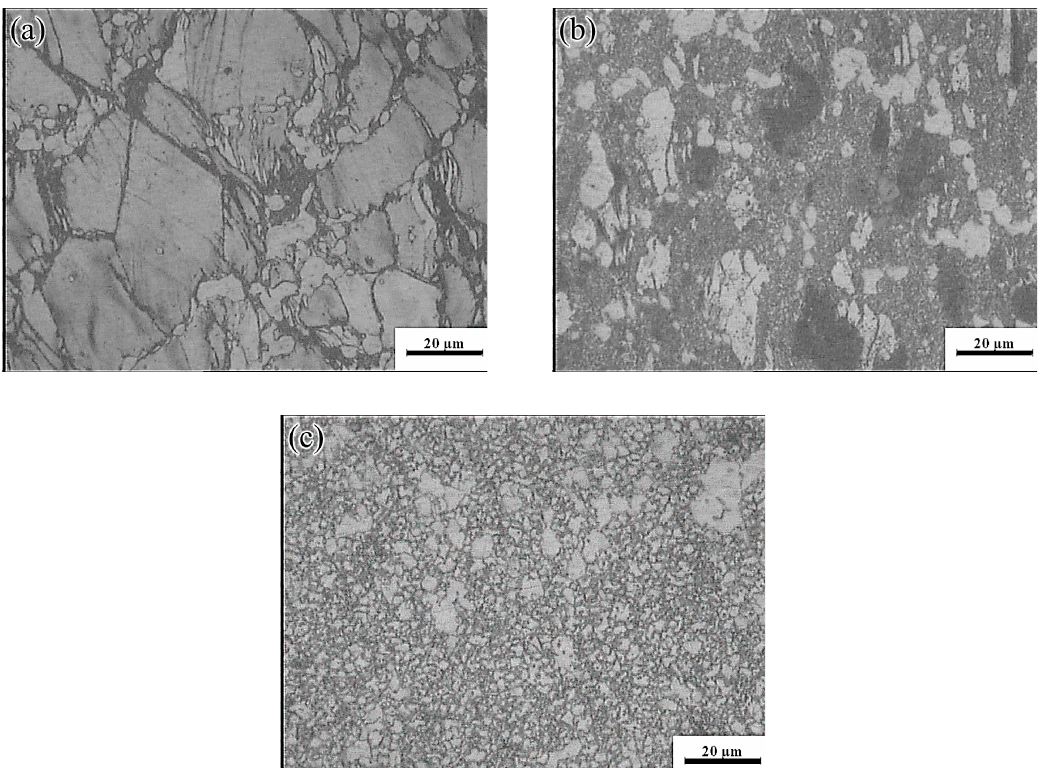
Figure 18. Microstructures of the Mg-16Al Mg alloy in Domain II: ( a ) 523 K / 0 0.1 s − 1 , ( b ) 573 K / 0 0.1 s − 1 , and ( c ) 623 K / 0 0.1 s − 1 .